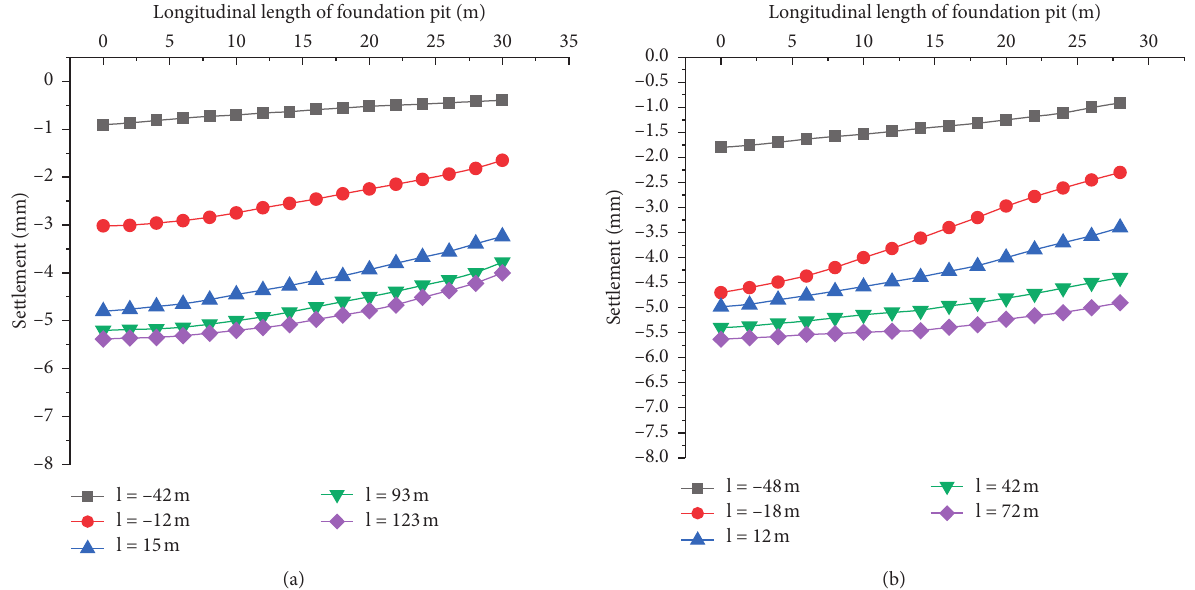
Figure 8: Relationship between face distance and lateral settlement of foundation pit. (a) No. 1 foundation pit near tunnel side. (b) No. 2 foundation pit near tunnel